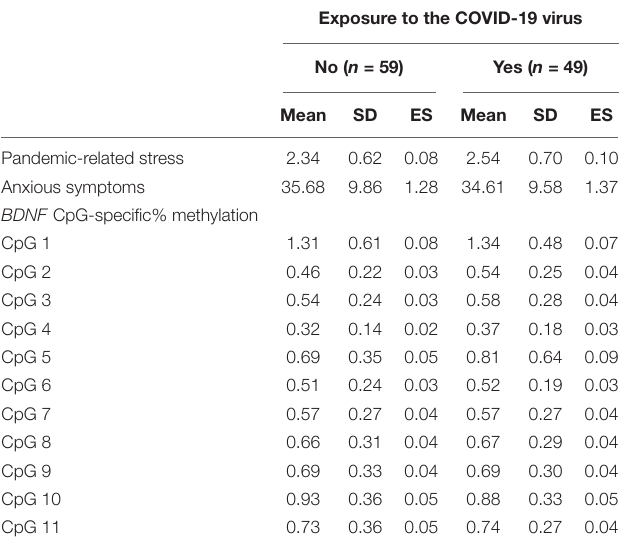
TABLE 4 | Comparison between mothers with and without any direct or indirect exposure to the COVID-19 during pregnancy for variables of interest. Exposure to the COVID-19